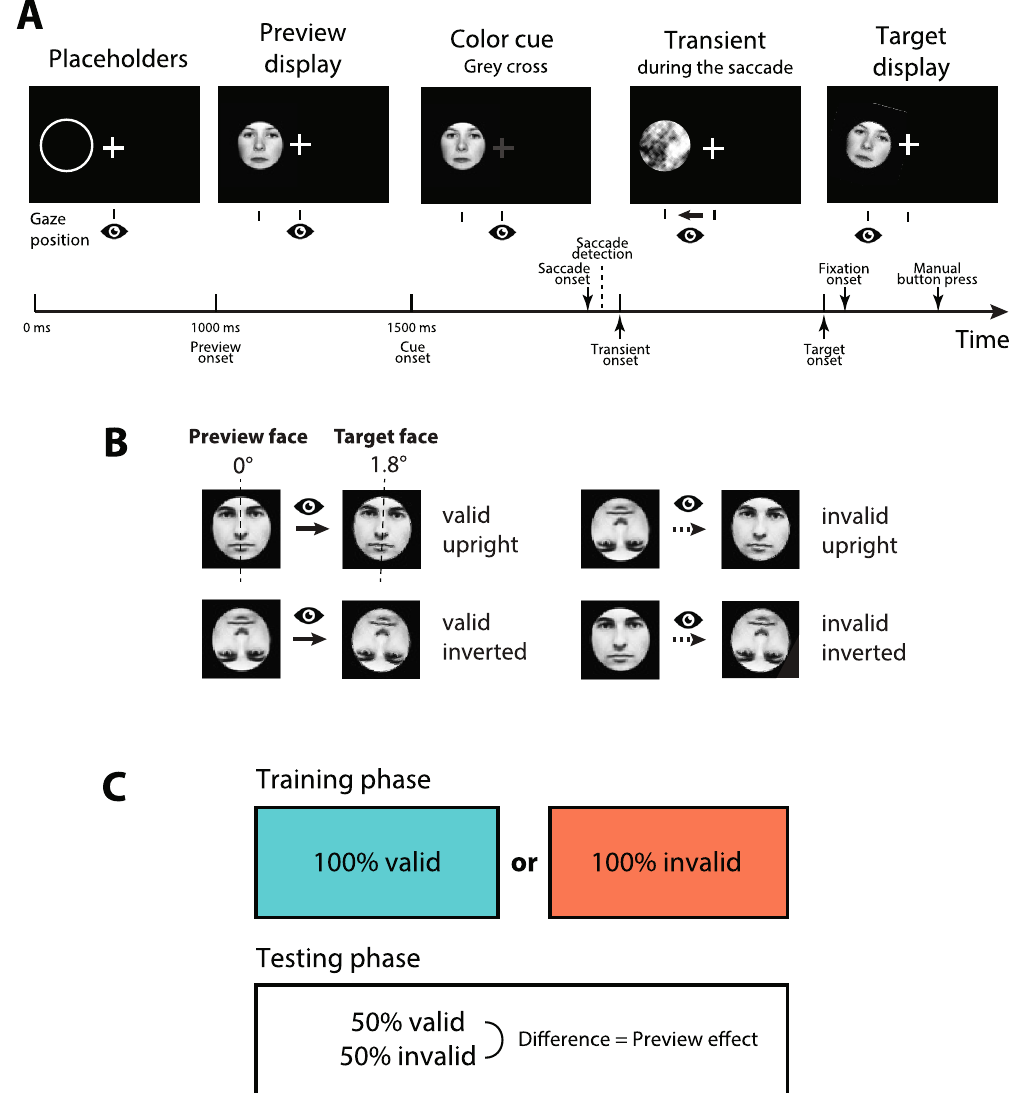
Figure 1. Trial procedure and experimental design. ( A ) Example of a valid preview trial with an upright target face. Stable gaze during the placeholder and preview periods made the fixation cross turn grey which cued the participant to look at the face. During the saccade, a visual transient equated low-level visual changes for valid and invalid trials. In most of the trials, the target face was presented before fixation onset. It had a small tilt which had to be reported by button press upon fixation. Stimuli, target face tilt and timeline are not drawn to scale. ( B ) All possible within-participant conditions of Target Orientation (upright, inverted) and Preview (valid, invalid). Only the target face was slightly tilted which had to be reported by manual button press. ( C )Between- participants training setup. Each participant performed a training phase with either only valid or only invalid trials. After the training phase, the preview effect, i.e. difference in tilt discrimination performance between valid and invalid trials, was measured in a separate test phase with an equal amount of valid and invalid trials. (Face stimuli taken from the Nottingham face data base, http://pics.stir.ac.uk/zips/notti ngham